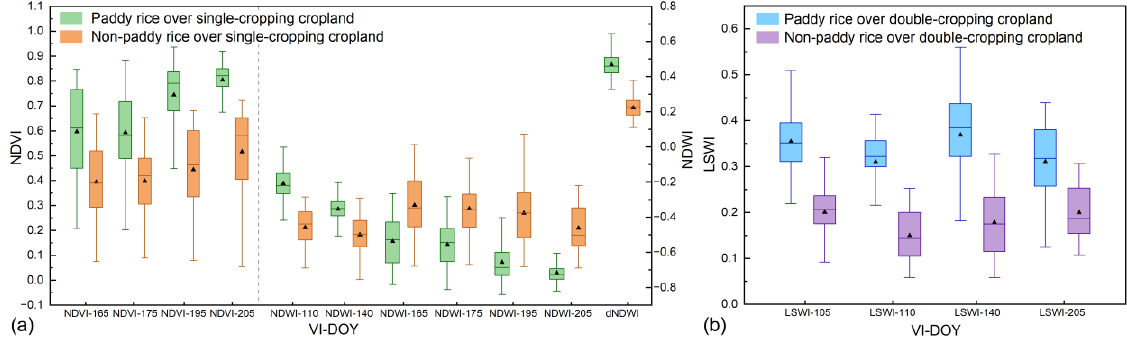
Figure 9. Boxplot of the critical VIs on specific observation dates for distinguishing paddy rice and non-paddy rice in the ( a ) single- and ( b ) double-cropping groups. The dNDWI was calculated by the difference between the flooding stage (DOY 110–140) NDWI and the peak-growth stage (DOY 195–205) NDWI. The boxes represent the 25th to 75th percentiles, and the bars show the 1.5 interquartile range. Lines and triangles stand for median and mean values, respectively.